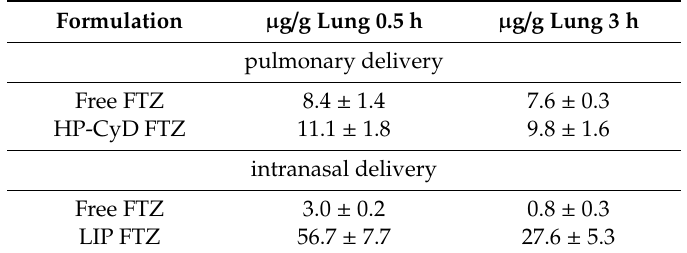
Table 5. Comparison of administration routes for FTZ: Pulmonary vs. i.n.